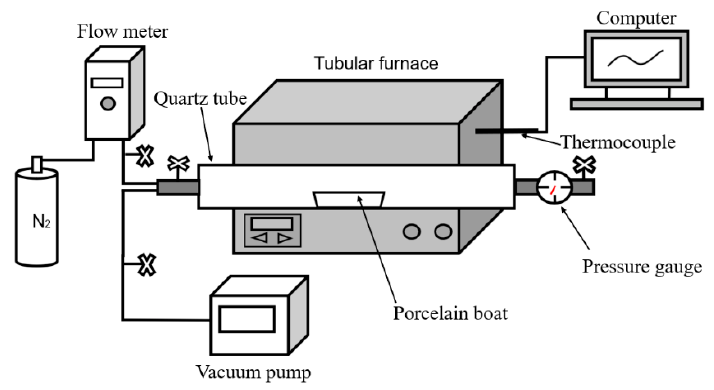
Figure 1. Diagram of apparatus of pyrolysis.